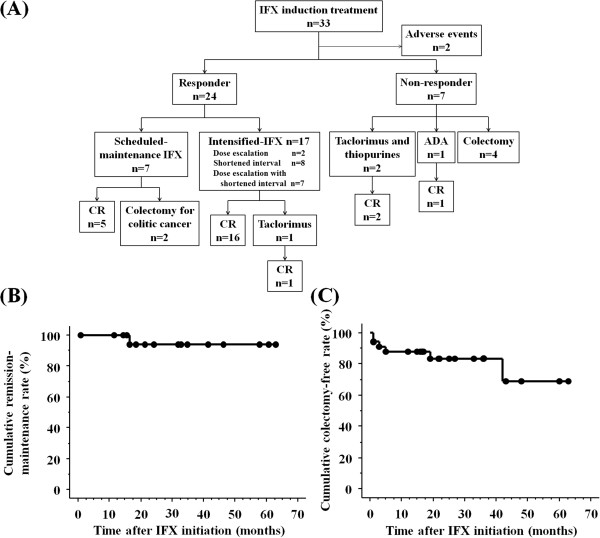
Clinical course and survival curves of UC patients treated with IFX. (A) Clinical course of UC patients who received IFX induction treatment. (B) Cumulative remission maintenance rate in 24 responders to IFX maintenance treatment, including IFX intensification. (C) Cumulative colectomy-free rate in patients who received IFX treatment during follow up.